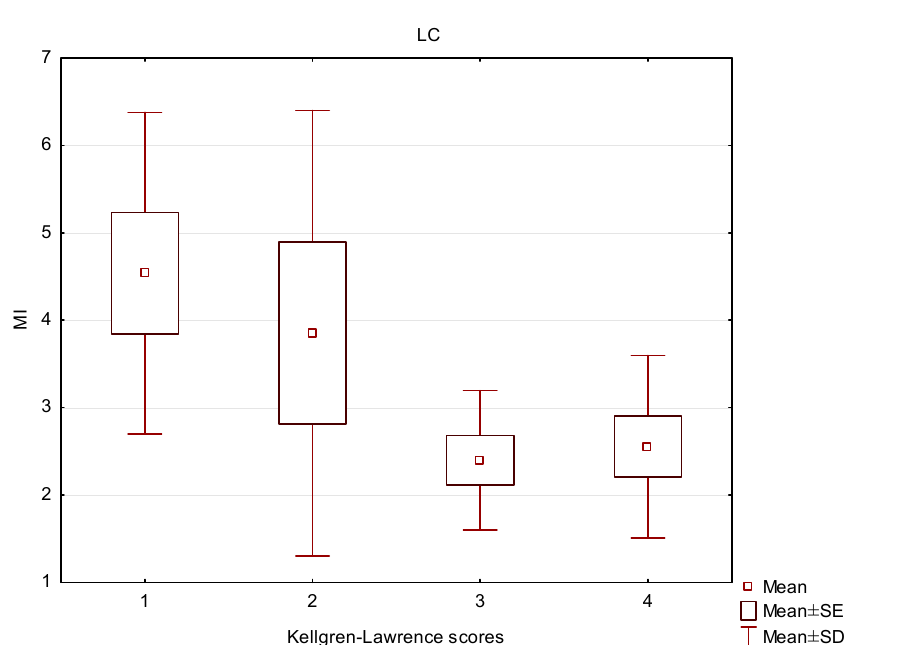
Figure 13. Box and whisker plot of the mineralization index (MI) in patients with different Kellgren– Lawrence scores in the medial condyle (MC).